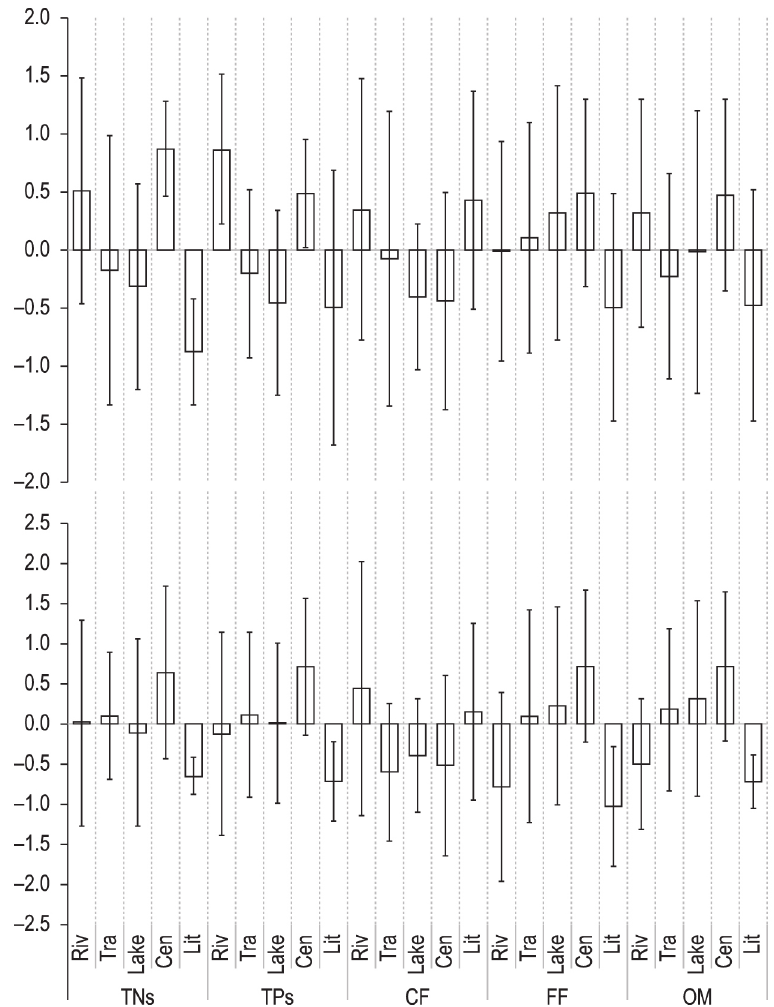
Figure 6. Average z scores by season (the superior refers to the wet season and the inferior to the dry season) considering the longitudinal and transversal gradients: riverine (Riv), transitional (Tra) and lacustrine (Lake) zones; central (Cen) and littoral (Lit) regions. The variables recorded here are: total nitrogen in the sediment (TNs), total phosphorous in the sediment (TPs), coarse inorganic fraction of sediment (CF), fine inorganic fraction of sediment (FF), organic matter in the sediment (OM). Errors bars represent the standard deviation in relation to the scores